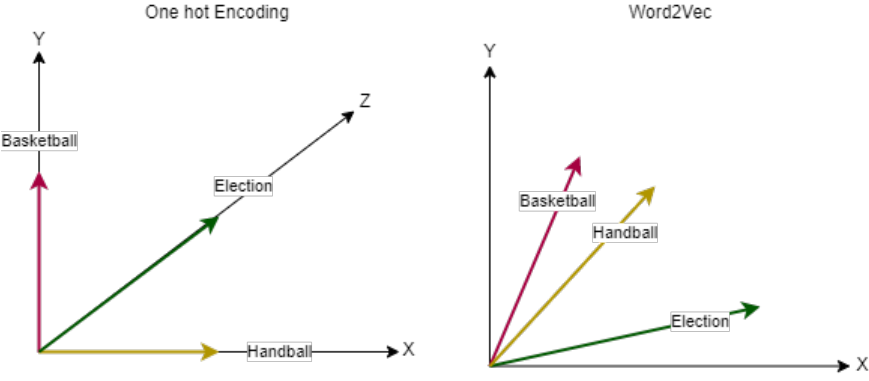
Figure 4. The representation of one-hot-encoded vectors vs. word2vec vectors.